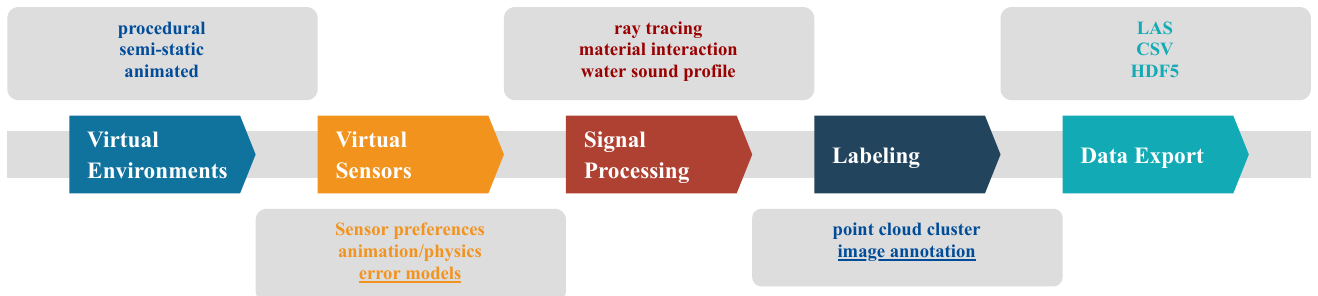
Figure 3. The graph includes the modularized structure of the BLAINDER add-on. The individual submodules are presented in detail in the following chapters. The modularization allows complete adaptability of the add-on to other specific